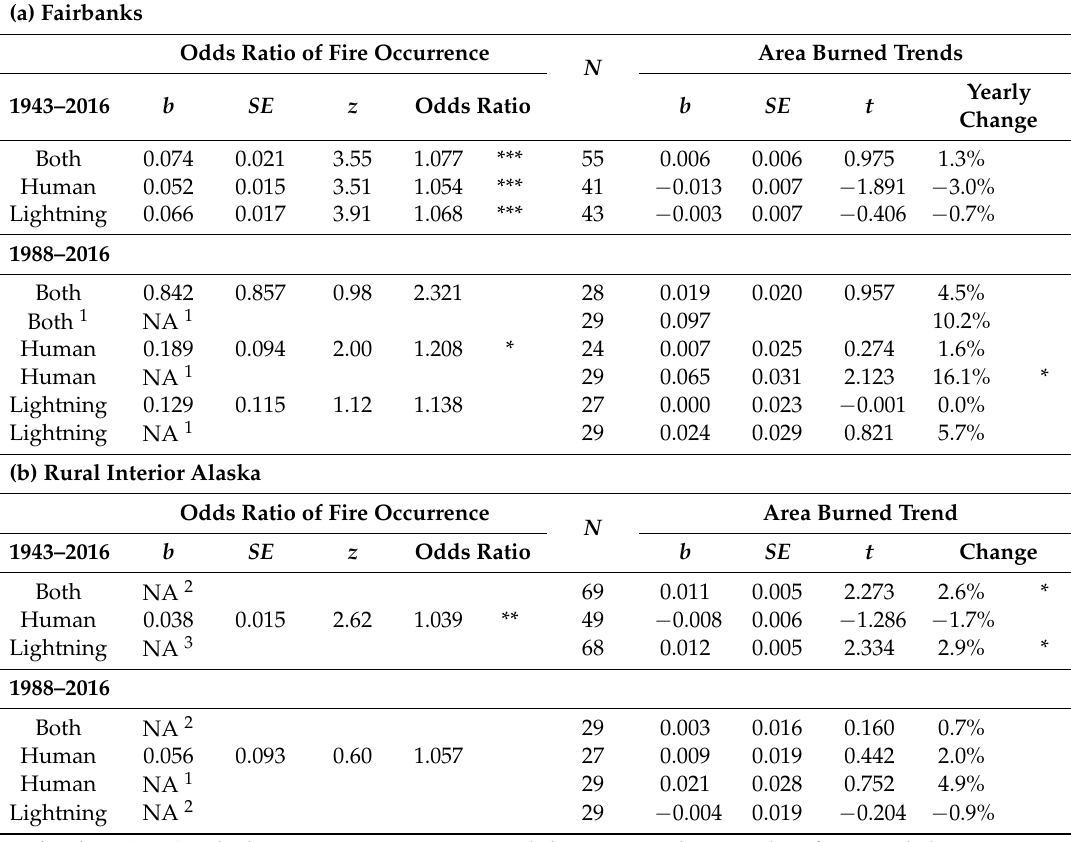
Table 1. Probability of a fire occurring in any given year using logistic regression analysis for odds ratio and log-linear regression of temporal trends in area burned [using log 10 (annual area burned) > 0 ha unless noted otherwise] in ( a ) the Fairbanks subregion, and ( b ) rural interior